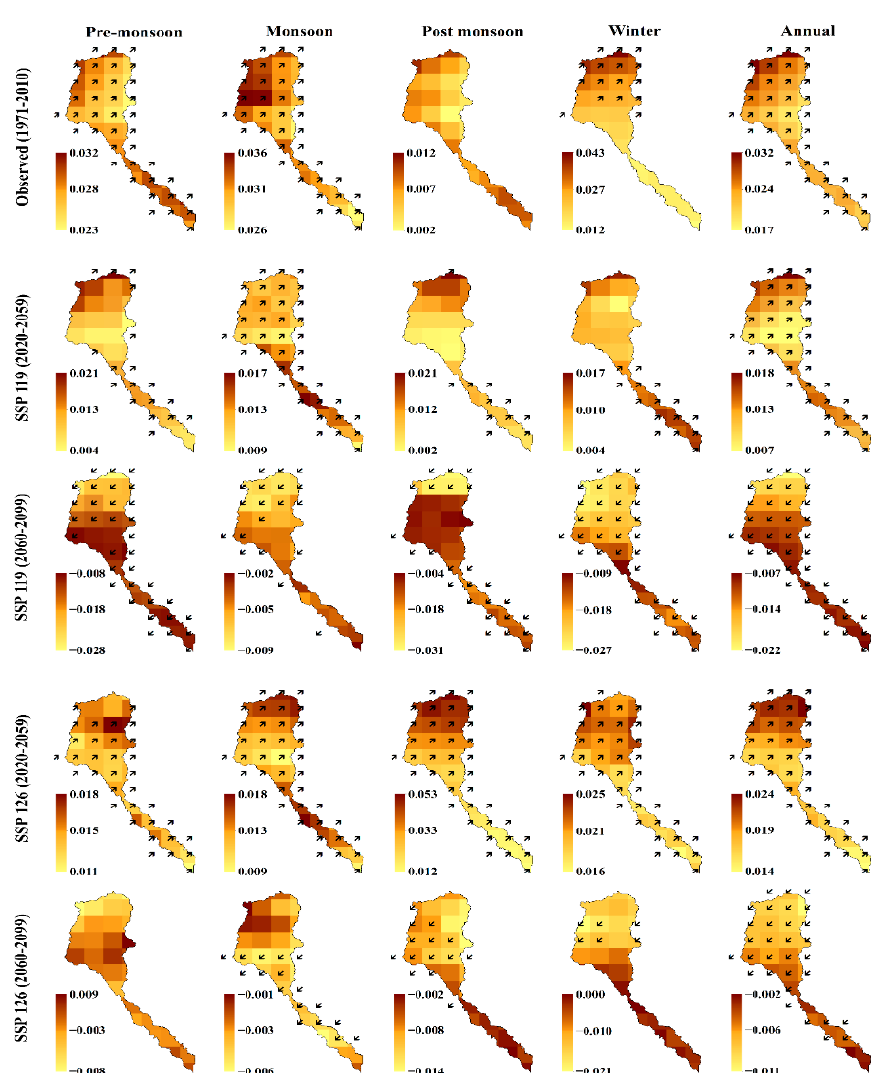
Figure 4. Spatial distribution of trend (significant at 95% confidence level) and magnitude in the seasonal and annual series of T min during the observational and future period (tilted upward arrow denotes significant increasing trend and vice versa).